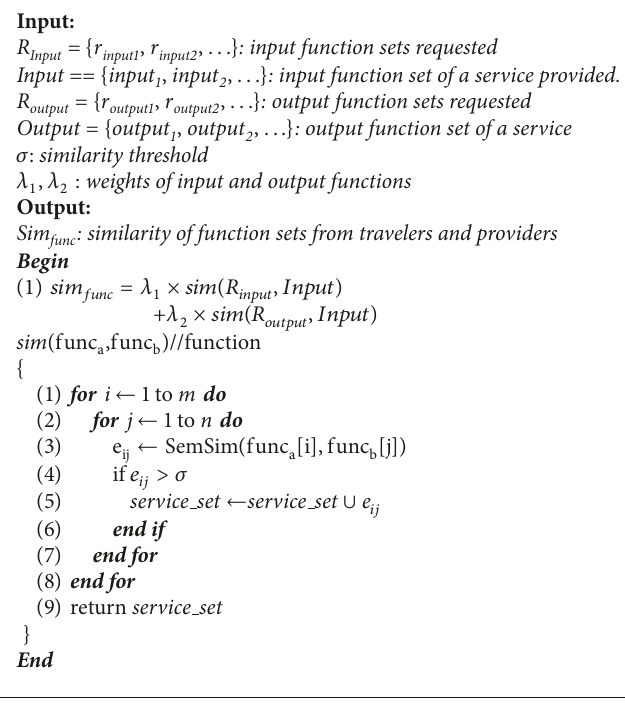
Algorithm 2: Functional